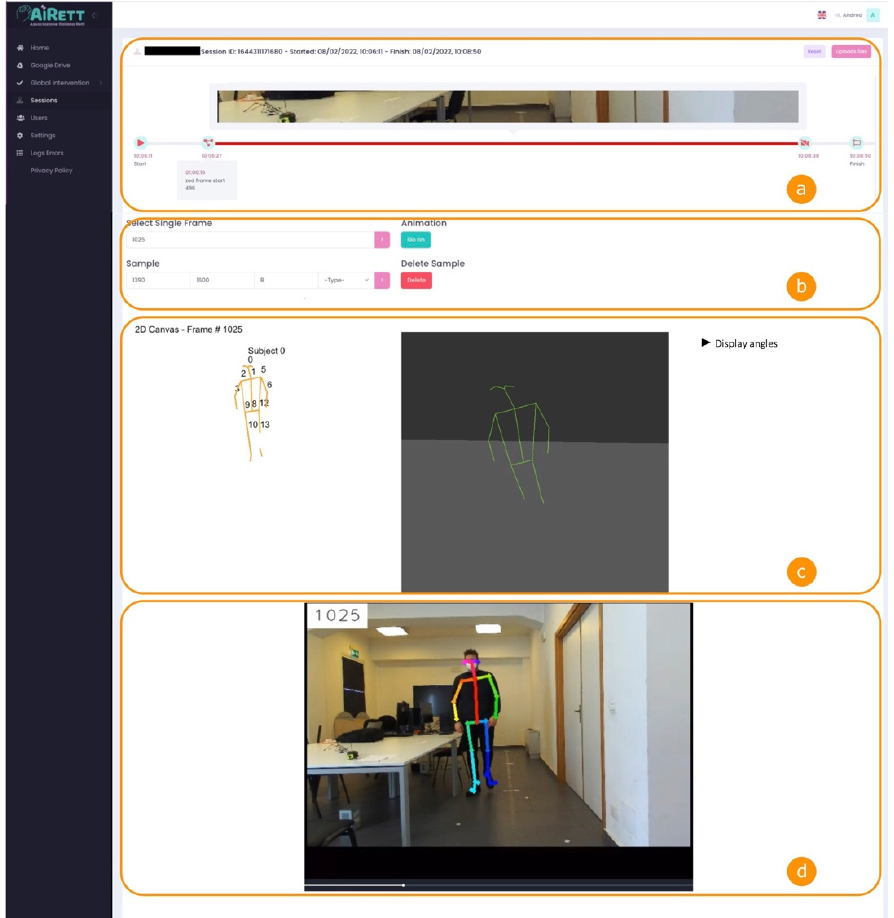
Figure 6. Telerehabilitation software interface for patient assessment. In (a) thumbnails of the telerehabilitation session video recordings are shown; (b) contains the form to select the frame number that the therapist wants to analyze; in (c) 2D and 3D skeleton are depicted, and measurements about joints’ angles are shown; (d) displays the video recordings with skeleton, frame number and therapist’s comments overlayed.